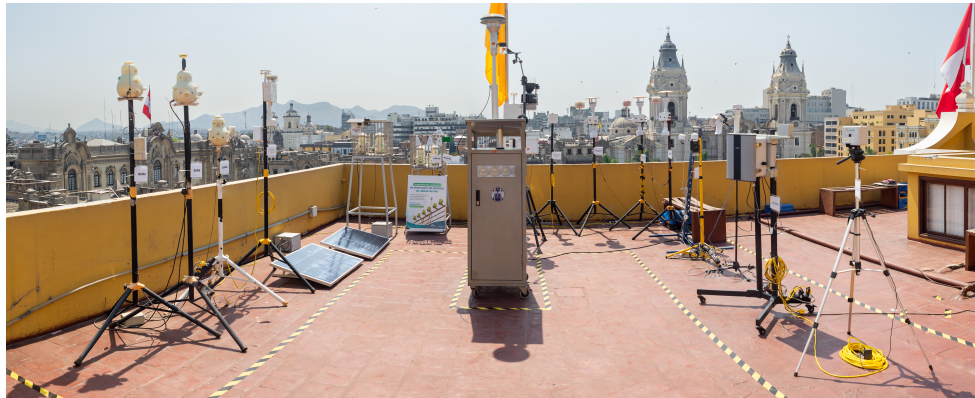
Figure 1. Place of the data collection campaign and the arrangement of the sensors. The reference station (Teledyne) is located in the center.